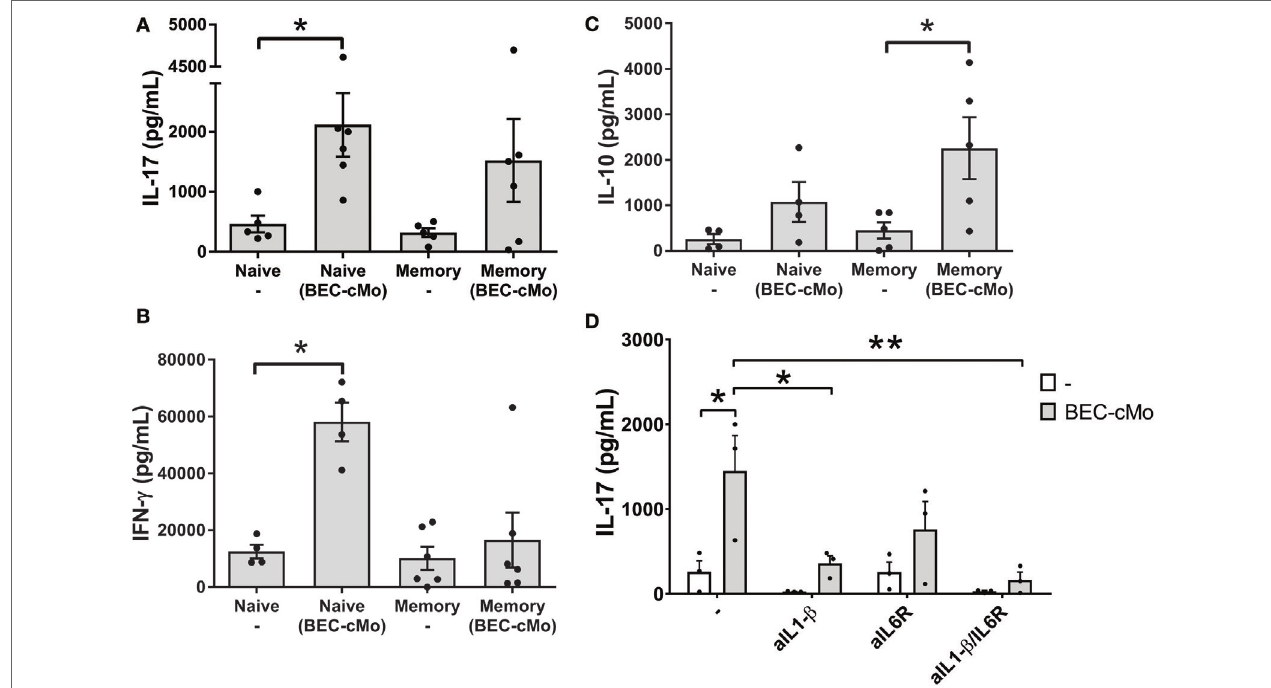
FigUre 4 | Monocytes cultured in bronchial epithelial cell-conditioned media (Bec-cM) have an increased ability to trigger the differentiation of human naive T cells into il-17 producers . Allogenic Naive T cells or Memory T cells were stimulated with conditioned monocytes [cultured with medium alone or with BEC-CM (BEC-cMo)] at a monocyte:T-cell ratio of 1:10 for 9 days, supplemented with IL-2 for the last 2 days and then stimulated for 5 h with PMA and ionomycin. Supernatants were analyzed for the release of (a) IL-17, (B) IFN- γ , and (c) IL-10. Data are expressed as means ± SEM of four to six independent experiments. Statistical analysis was performed using a Mann–Whitney test (* P < 0.05). (D) Production of IL-17 by naive T-cells primed with allogenic monocytes that were cultured with medium alone or with BEC-CM at a monocytes:T-cell ratio of 1:10. During the mixed lymphocyte reaction, cells were cultured in the presence of neutralizing antibodies to IL-1 β , IL-6R, or both. Data are expressed as mean ± SEM of three independent experiments. Statistical analysis was performed using analysis of variance test (followed by Tukey multiple comparisons test) (* P < 0.05, ** P <